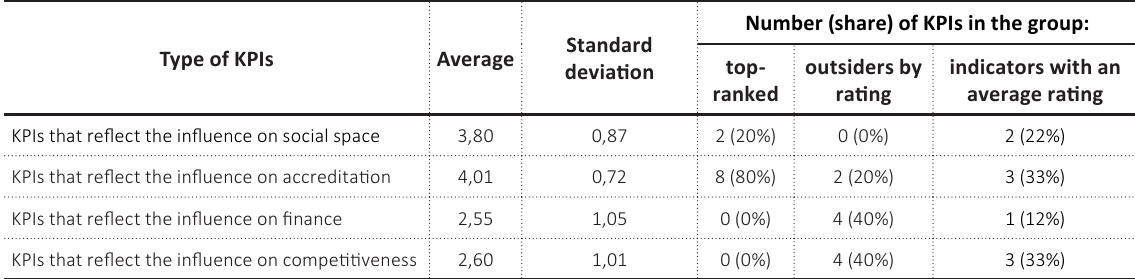
Table 1. The average rating for the KPI groups connected with accreditation, competitiveness, financial support, and social